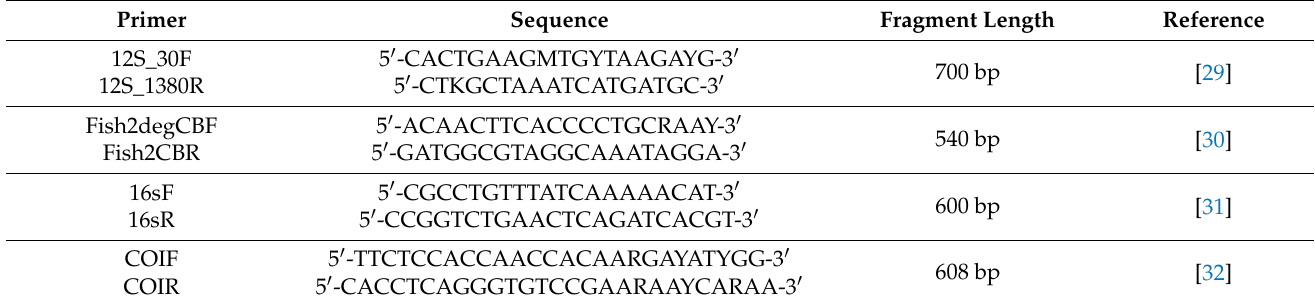
Table A1. Primer pairs name, sequence, and amplicon